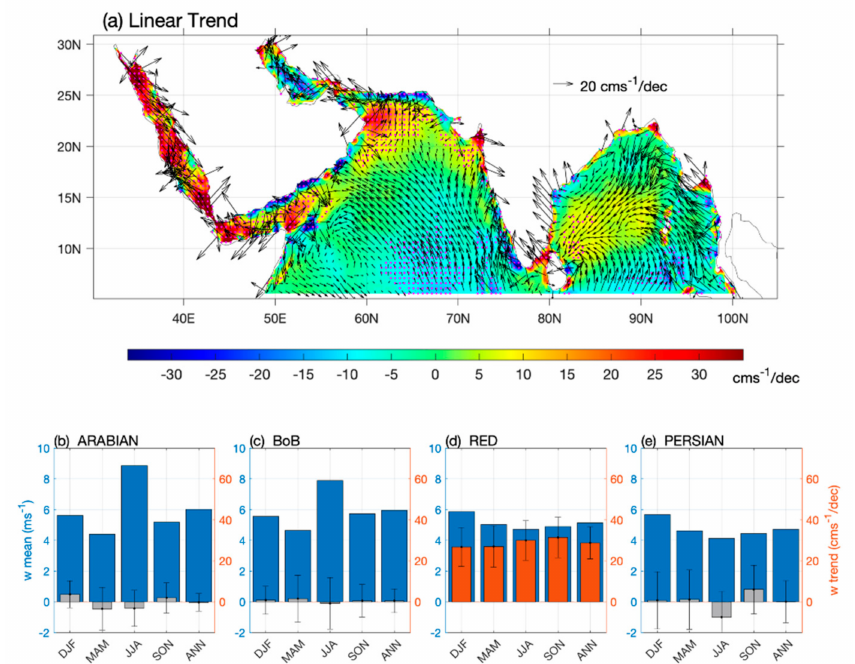
Figure 10. ( a ) Linear trends of annual-mean surface wind speed and vector subsetted from Figure 8a for the North Indian Ocean marginal seas. The magenta dotted areas denote the linear trends of wind speed that are significant at the 90% confidence interval. ( b – d ) Bar plots of the basin-averaged mean values (blue bars, left y -axis) and linear trends (red and gray bars, right axis) of wind speed in four seasons: December-January-February (DJF), March-April-May (MAM), June-July-August (JJA), and September-October-November (SON) and the total annual mean (ANN) for ( b ) ARABIAN: the Arabian Sea; ( c ) BoB: the Bay of Bengal; ( d ) RED: the Red Sea; and ( e ) PERSIAN: the Persian Gulf. Error bars denote the upper and lower limits of the 90% confidence intervals. Linear trends that are statistically significant (not significant) are colored by red